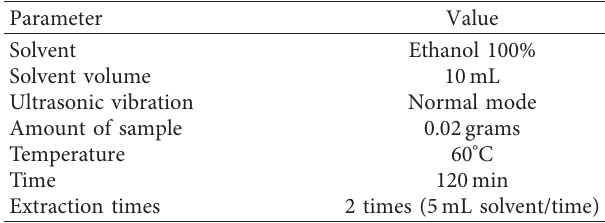
Figure 1: Chemical structures of Sudan I (a) and Sudan II (b). Table 1: Optimal sample extraction